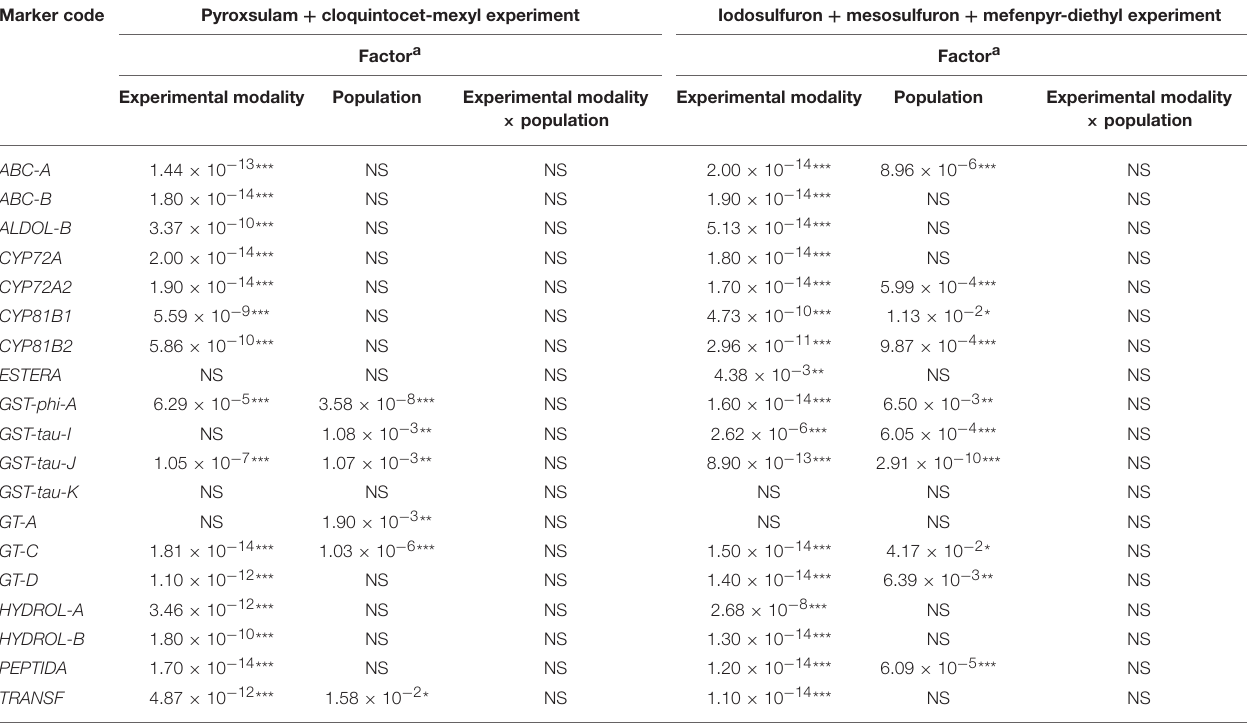
TABLE 3 | ANOVA of the effects of the experimental modality, of the population and of their interaction on the expression levels of 19 NTSR markers. Marker